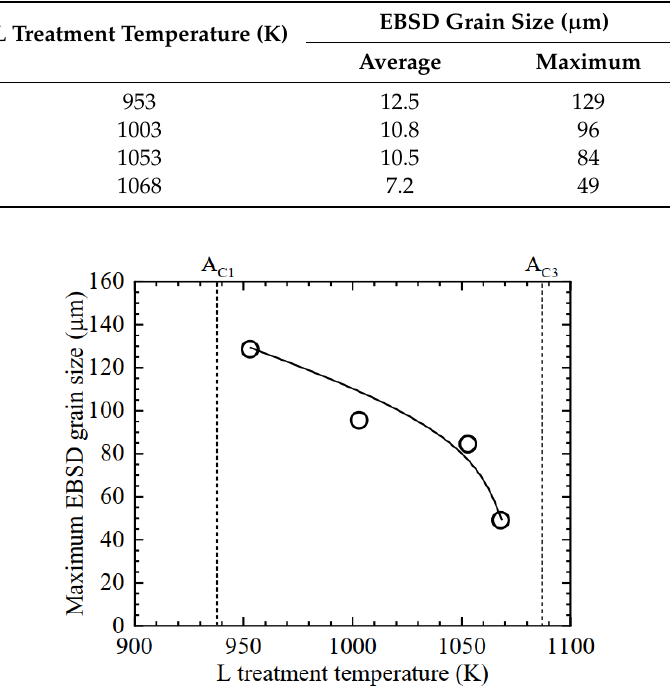
Figure 11. Relationship between L treatment temperature and maximum EBSD grain size.